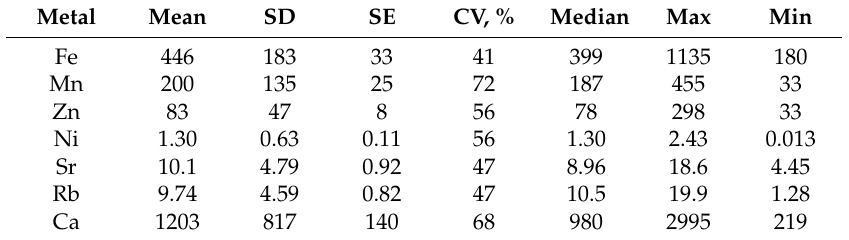
Table 1. Element concentrations in the H. physodes thallus in the Kaliningrad region, µ g/g DW.